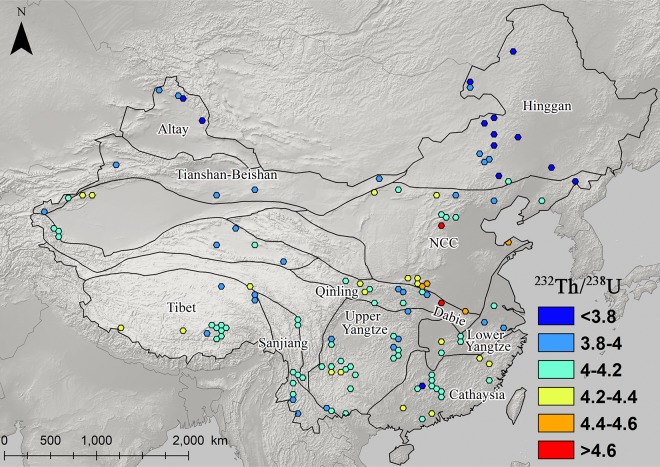
Map of 232Th/238U ratios for galena ores (n = 2,104).